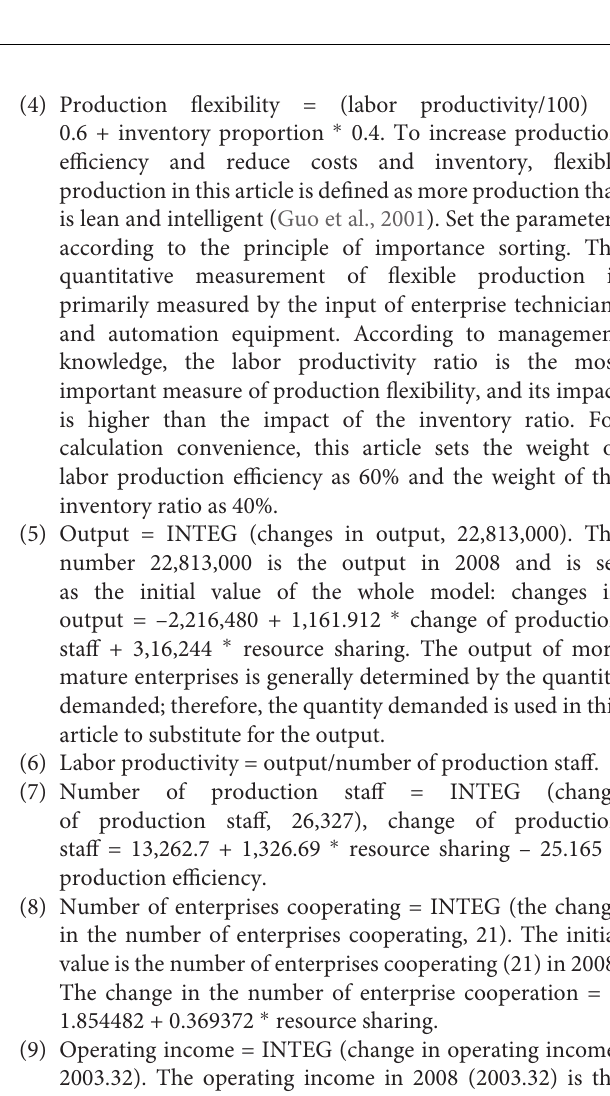
FIGURE 4 | System causal